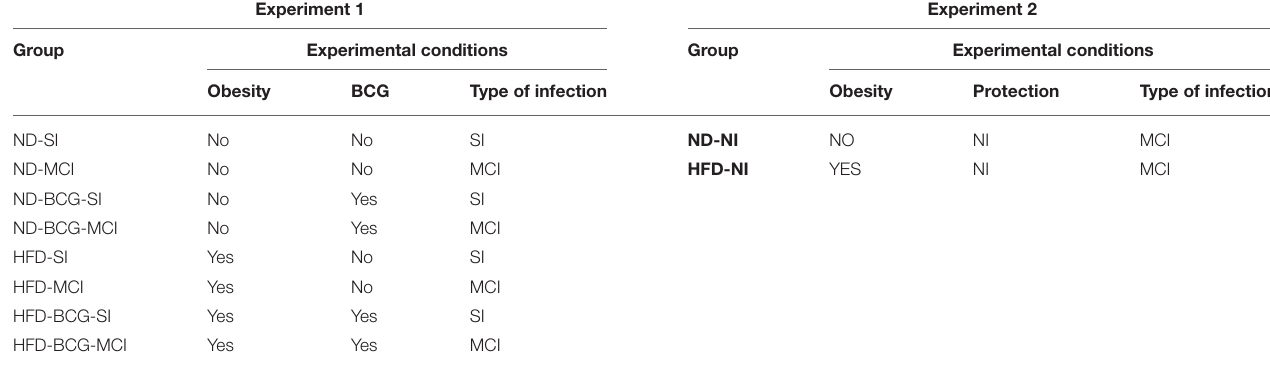
TABLE 2 | Experimental groups and conditions tested per